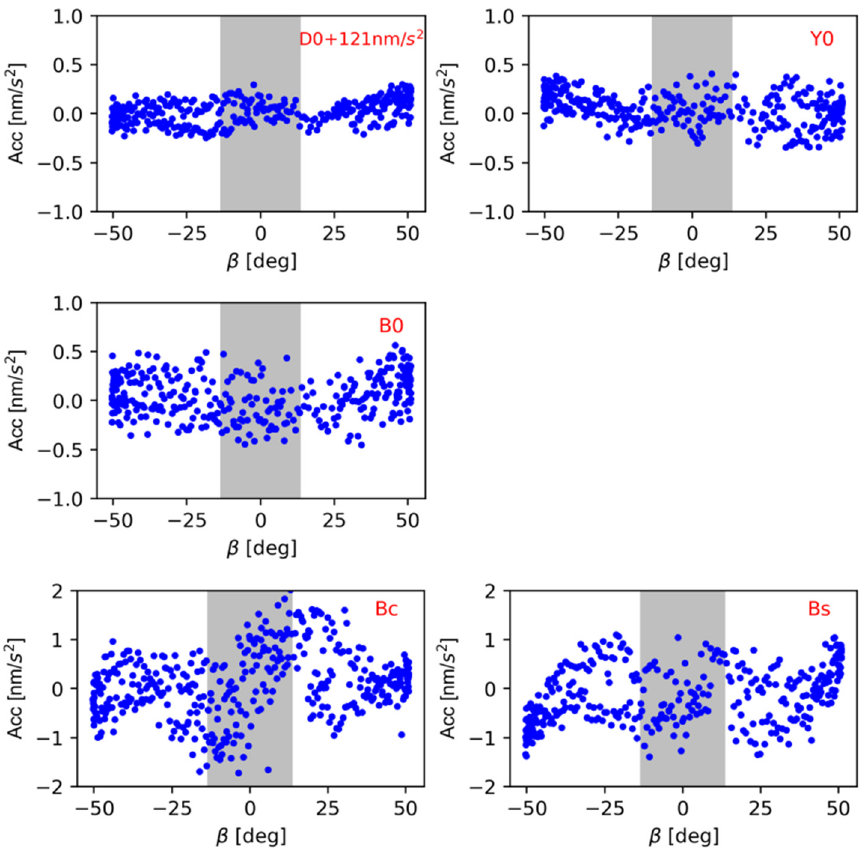
Figure 5. Estimated parameters of the ECOM SRP model for C13 orbit solutions (The areas shaded in grey indicate eclipse seasons).